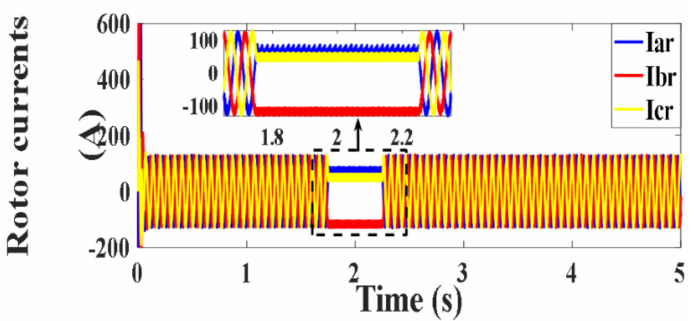
Figure 43. Rotor currents under MPDTC (A).